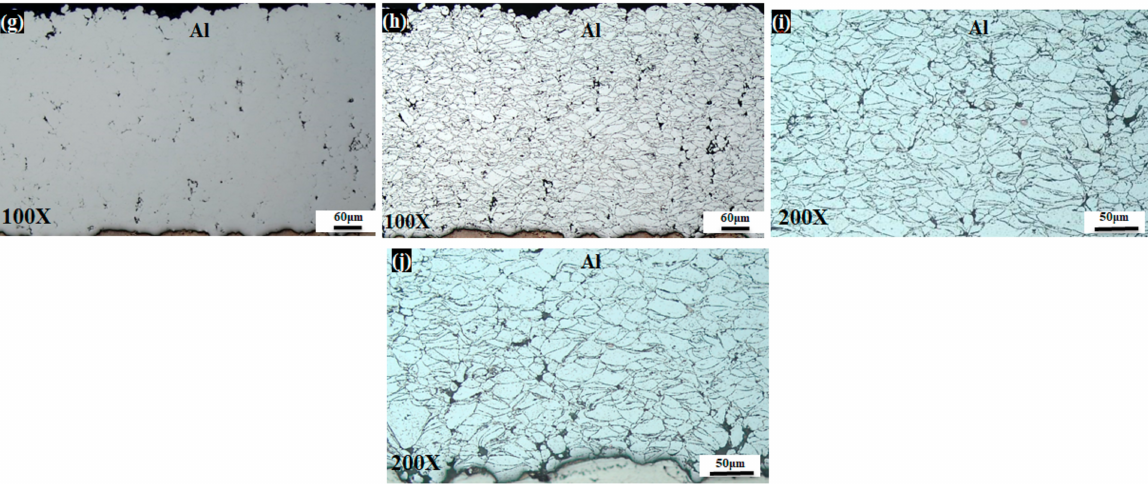
Figure 3. Photomicrographs from polished crossed section of ( a – e ) Ti-coated AZ31B at different magnifications, and ( f – j ) Al-coated AZ31B at different magnifications before and after